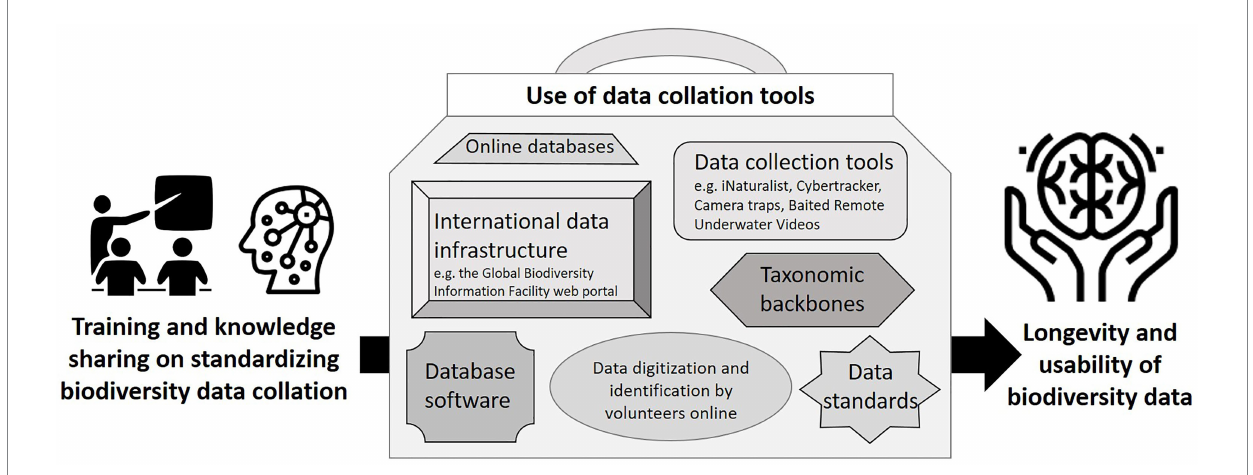
FIGURE 1 Tools to improve the collation of standardized biodiversity data for conservation. Further examples of resources for accessing biodiversity occurrence data to inform conservation decisions are provided in Supplementary material